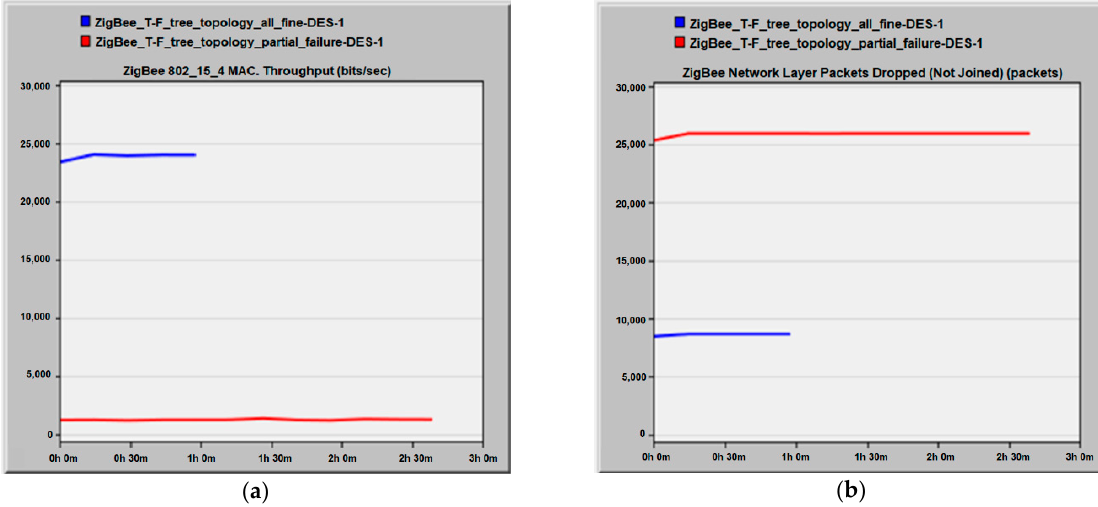
Figure 7. ( a ) Received management data in bits per second ; ( b ) Sent management data in bits per second .